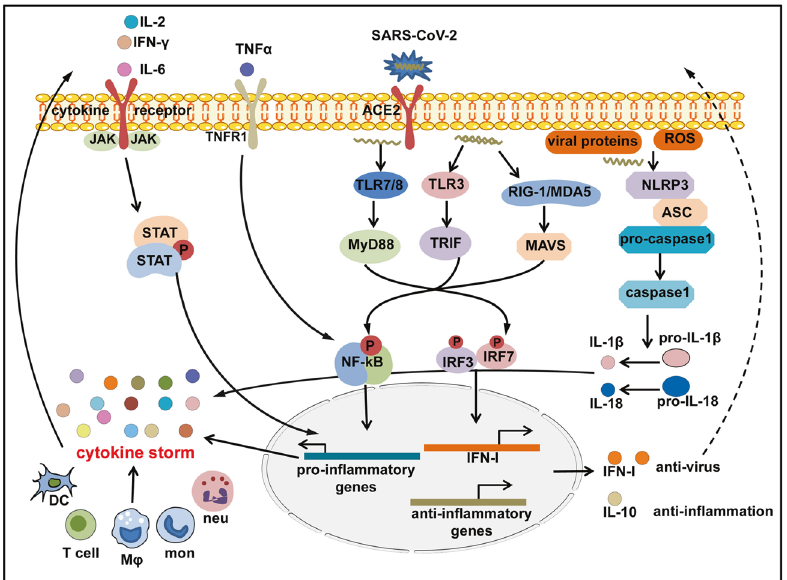
Fig. 5 In fl ammatory signaling cascades activated in COVID-CS. SARS-CoV-2 enters the host cells and is sensed by toll-like receptors (TLRs)3, 7, 8; RIG-I-like receptor, RIG-I or MDA5; and NOD-like receptor, NLRP3, that can also be directly activated by viral proteins or ROS released by apoptotic or in fl amed cells. The downstream transcription factors IRF3/7 are activated to induce the production of IFN-I and related paradoxical hyperin fl ammation; NF- κ B is activated to induce the production of pro-in fl ammatory cytokines; and NLRP3 in fl ammasome is activated to induce the production of mature IL-1 β and IL-18. Pro-in fl ammatory cytokines such as IL-6, IL-2, TNF- α , and IFN- γ in turn activate the JAK-STAT or NF- κ B signaling via binding to their receptors expressed on immune cells to induce more production of pro-in fl ammatory genes, forming a positive feedback to trigger the threshold of CS. Conversely, regulatory cytokines like IL-10 are compensatorily produced to antagonize immune